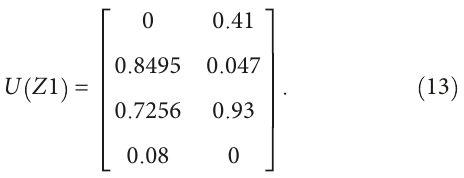
Water sample label